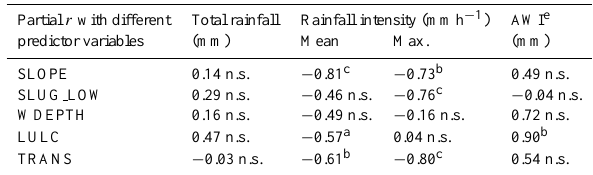
Table 5. Correlation coefficients highlighting the effect of rainfall characteristics and antecedent wetness on the strength of partial cor- relation coefficients. Displayed are linear correlation coefficients between partial r of the response variable W TNORM and different predictors and different rainfall characteristics and antecedent wet- ness. For rank partial correlation coefficients see Table 4; for rain- fall characteristics and antecedent wetness per temporal scale see Fig. 2 and Table 2. Only predictors showing a significant partial r for most temporal scales were chosen for correlation (SLOPE, SLUG LOW, WDEPTH, LULC, TRANS). Correlation with total rainfall n = 12 (all temporal scales), correlation with rainfall inten- sity n = 11 (seasonal and event scale), correlation with AWI n = 5 (event scale only).